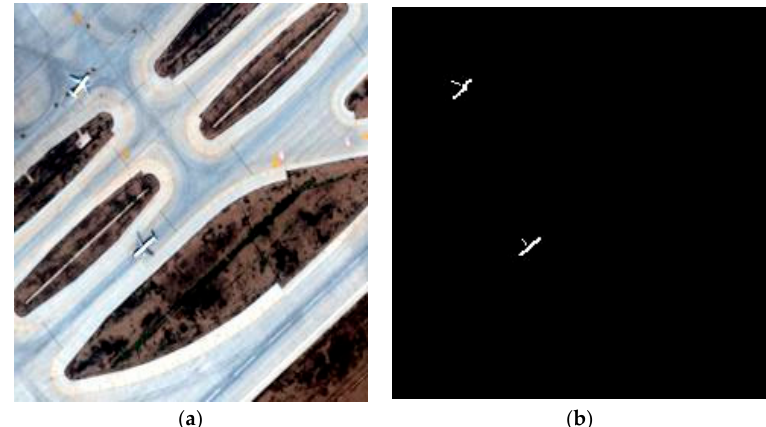
Figure 2. The first scene of the Xianyang Airport: ( a ) three band false color composite; and ( b ) reference data.